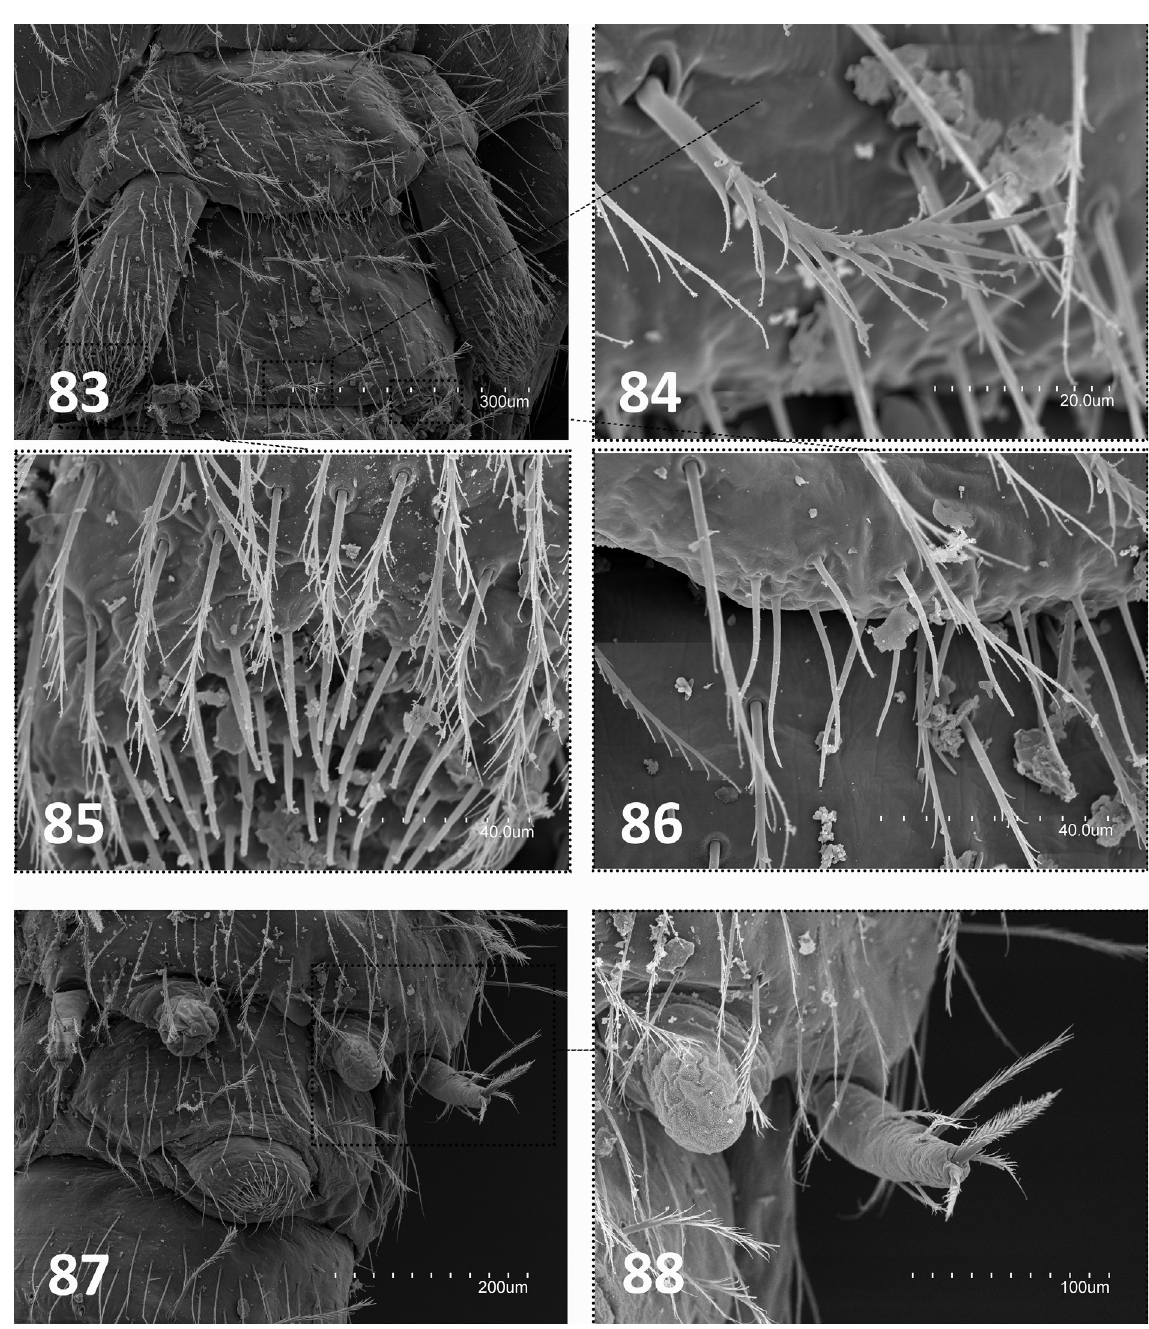
Figs 83–88. Plusiocampa ( Plusiocampa ) hoffmanni Sendra & Paragamian sp. nov., ♂, from Varathro Mythia Kabathoura, Rethymno, Crete (Coll. AS). 83 . Urosternites I–II. 84 . Macroseta on posterior portion of urosternite I. 85 . Tip of urosternal appendage. 86 . Latero-interior portion of posterior edge, with glandular g setae. 87 . Urosternites VII–IX. 88 . Left latero-posterior portion of urosternite 1